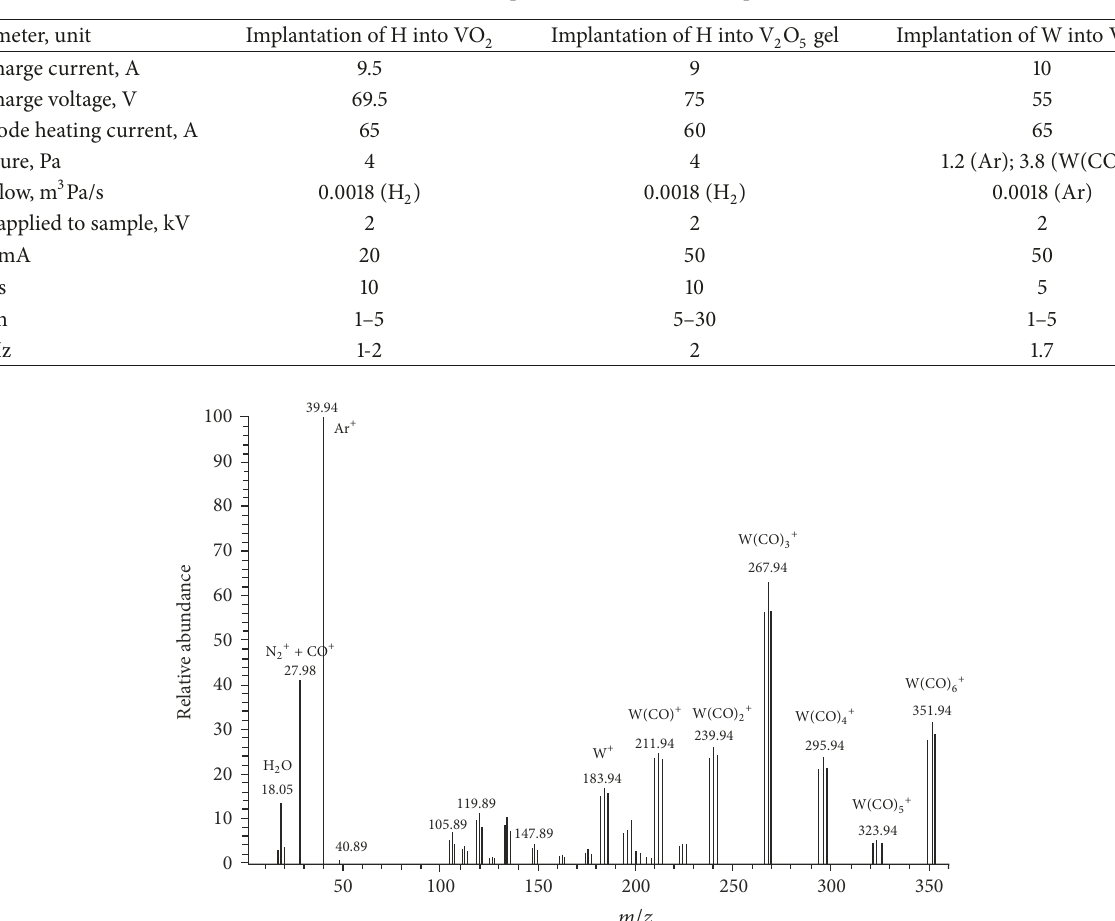
Table 1: Parameters of plasma-immersion ion implantation.